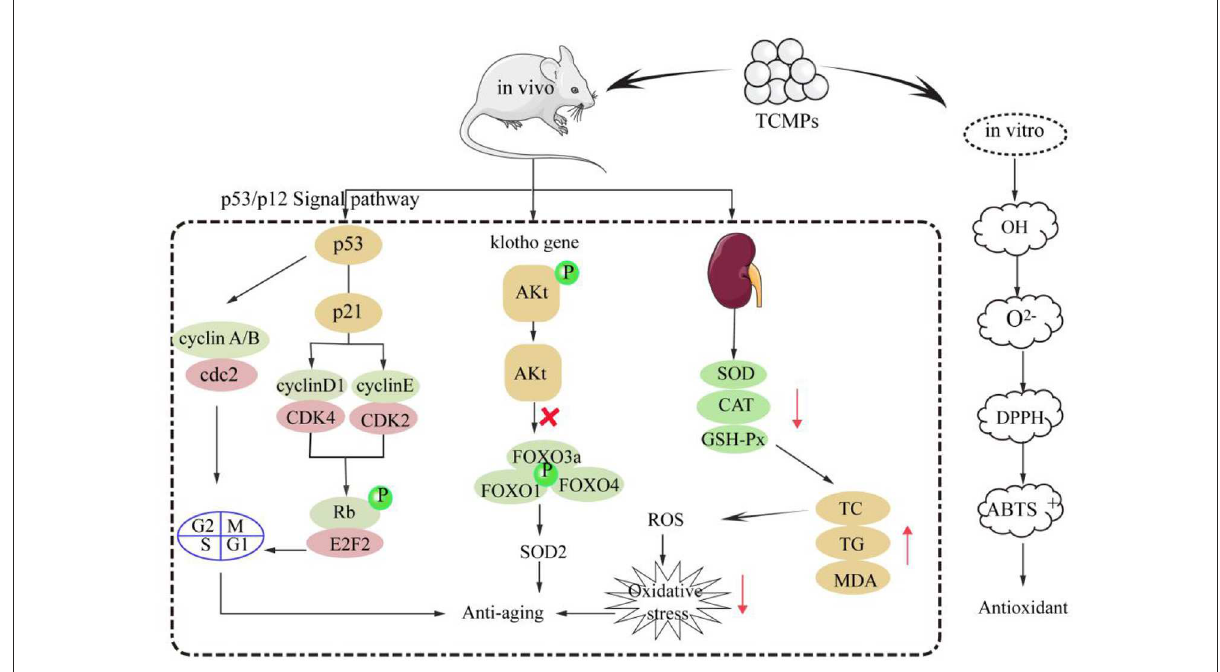
FIGURE3 The main antioxidant and anti-aging mechanisms of TCMPs.